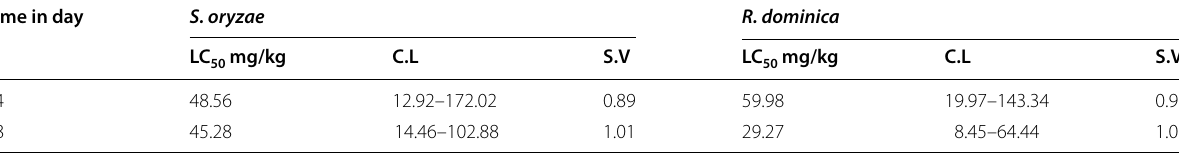
Table 2 Toxicity of lambda‑cyhalothrin against adults of S. oryzae and R. dominica at the indicated times post treatment Time in